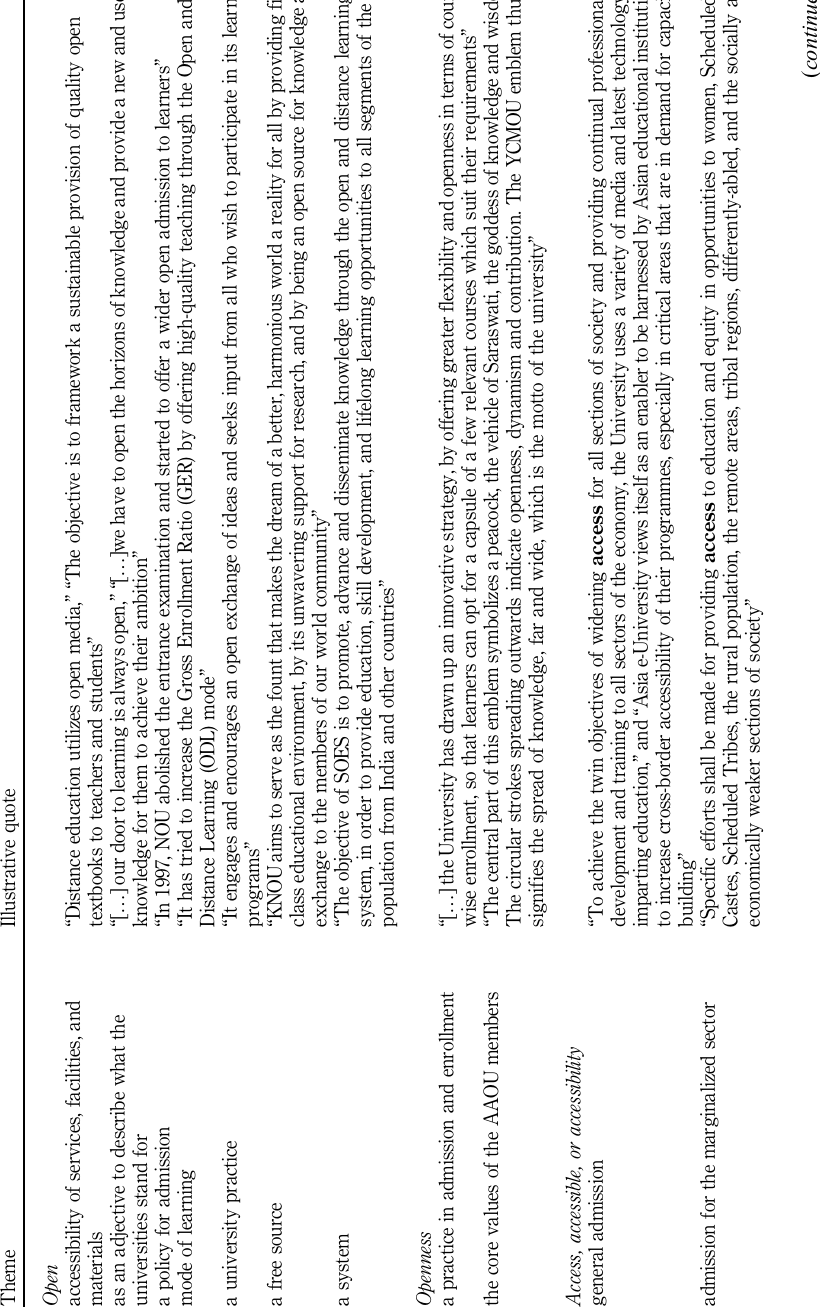
Table III. Results of